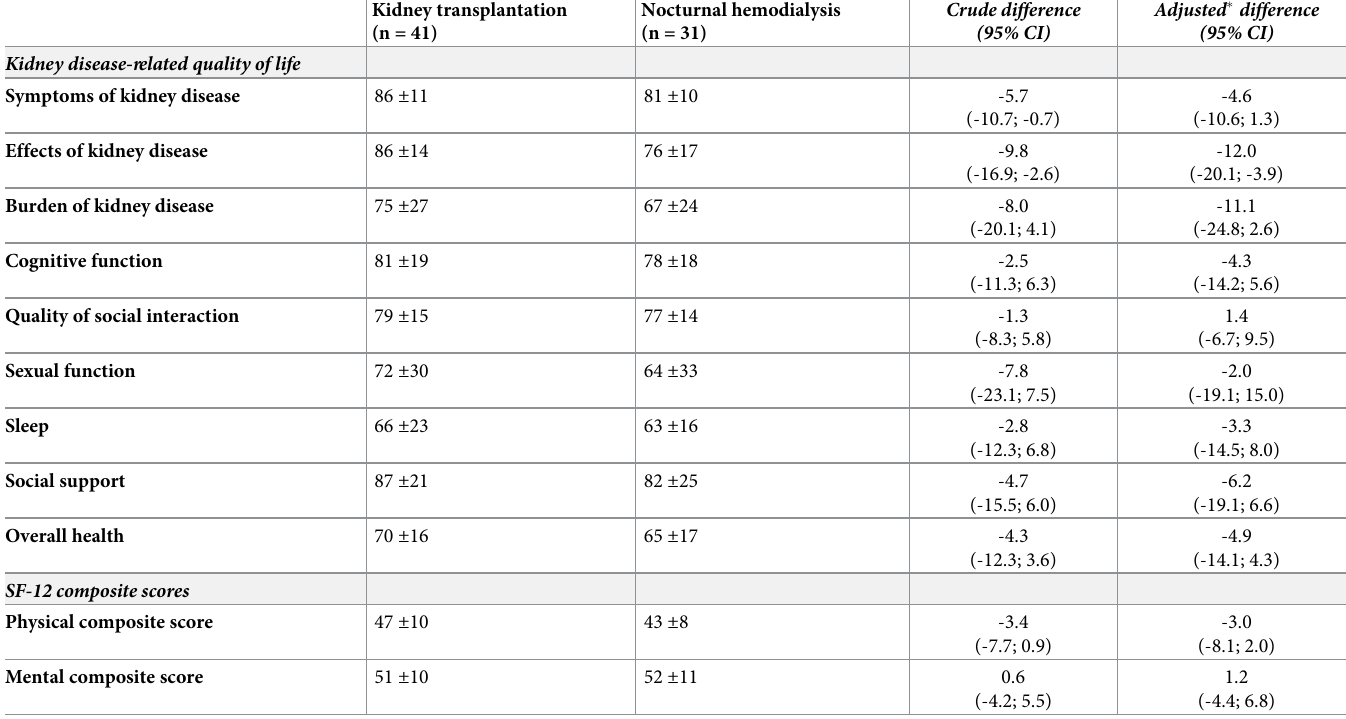
Table 3. Health-related quality of life scores and differences in scores between the 72 kidney transplant recipients and patients on nocturnal hemodialysis at one year of